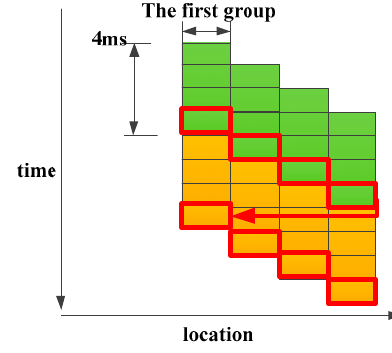
Figure 2. Flow of single–channel detection.